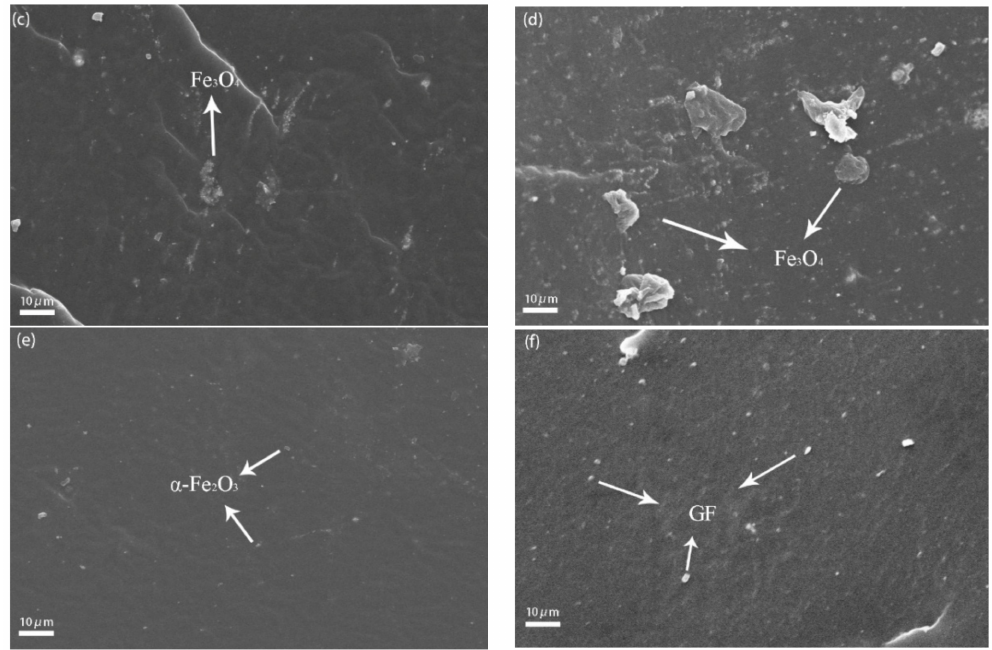
Figure 4. SEM images of ( a ) PBMA/0.5% Fe 3 O 4 composites; ( b ) PBMA/1% Fe 3 O 4 composites;